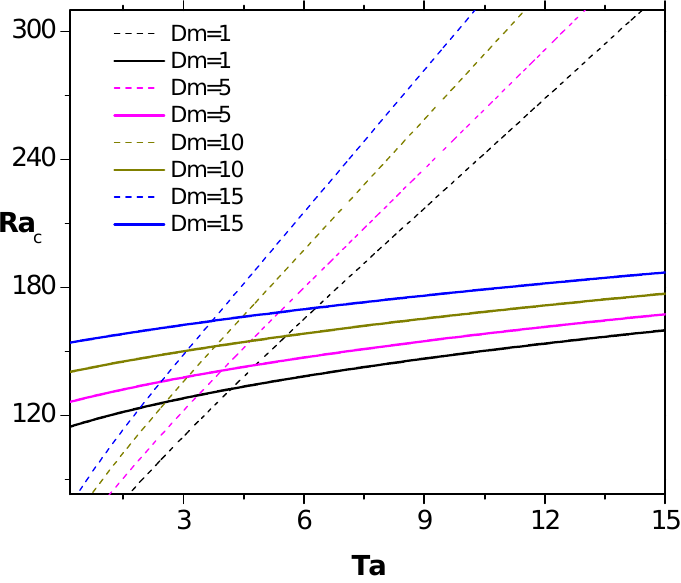
Figure 10. Plots of critical Ra as the function of Ta for Va = 15, Ha = 0.5, Dm = 1, 5, 10, 15. Similarly, Figure 10 depicts the effect of Dm on the system. From this figure, we see that the effect of increasing Dm is to increase the Ra sc